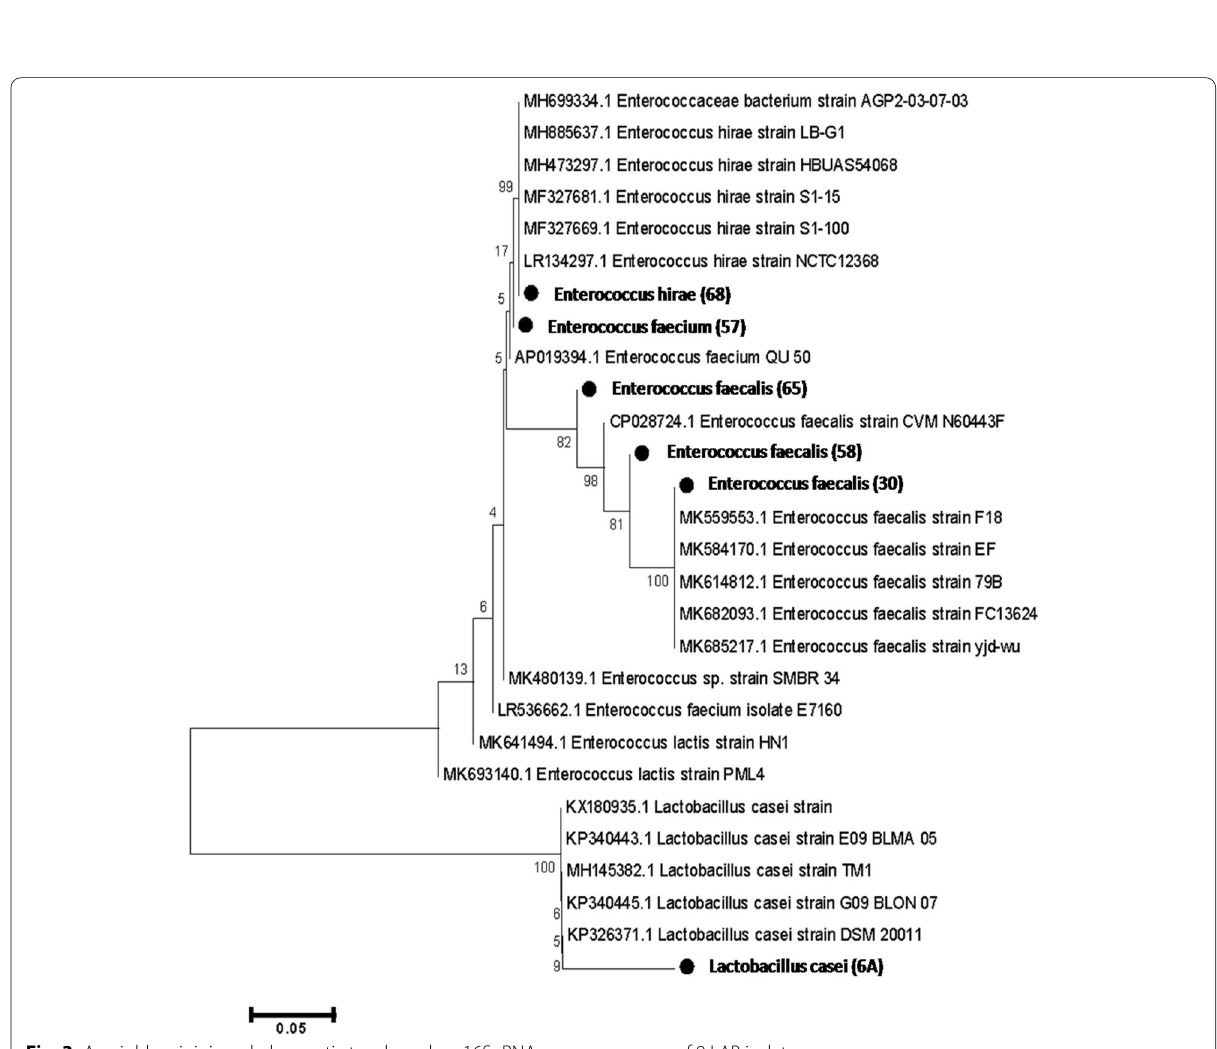
Fig. 3 A neighbor-joining phylogenetic tree based on 16S rRNA gene sequences of 9 LAB